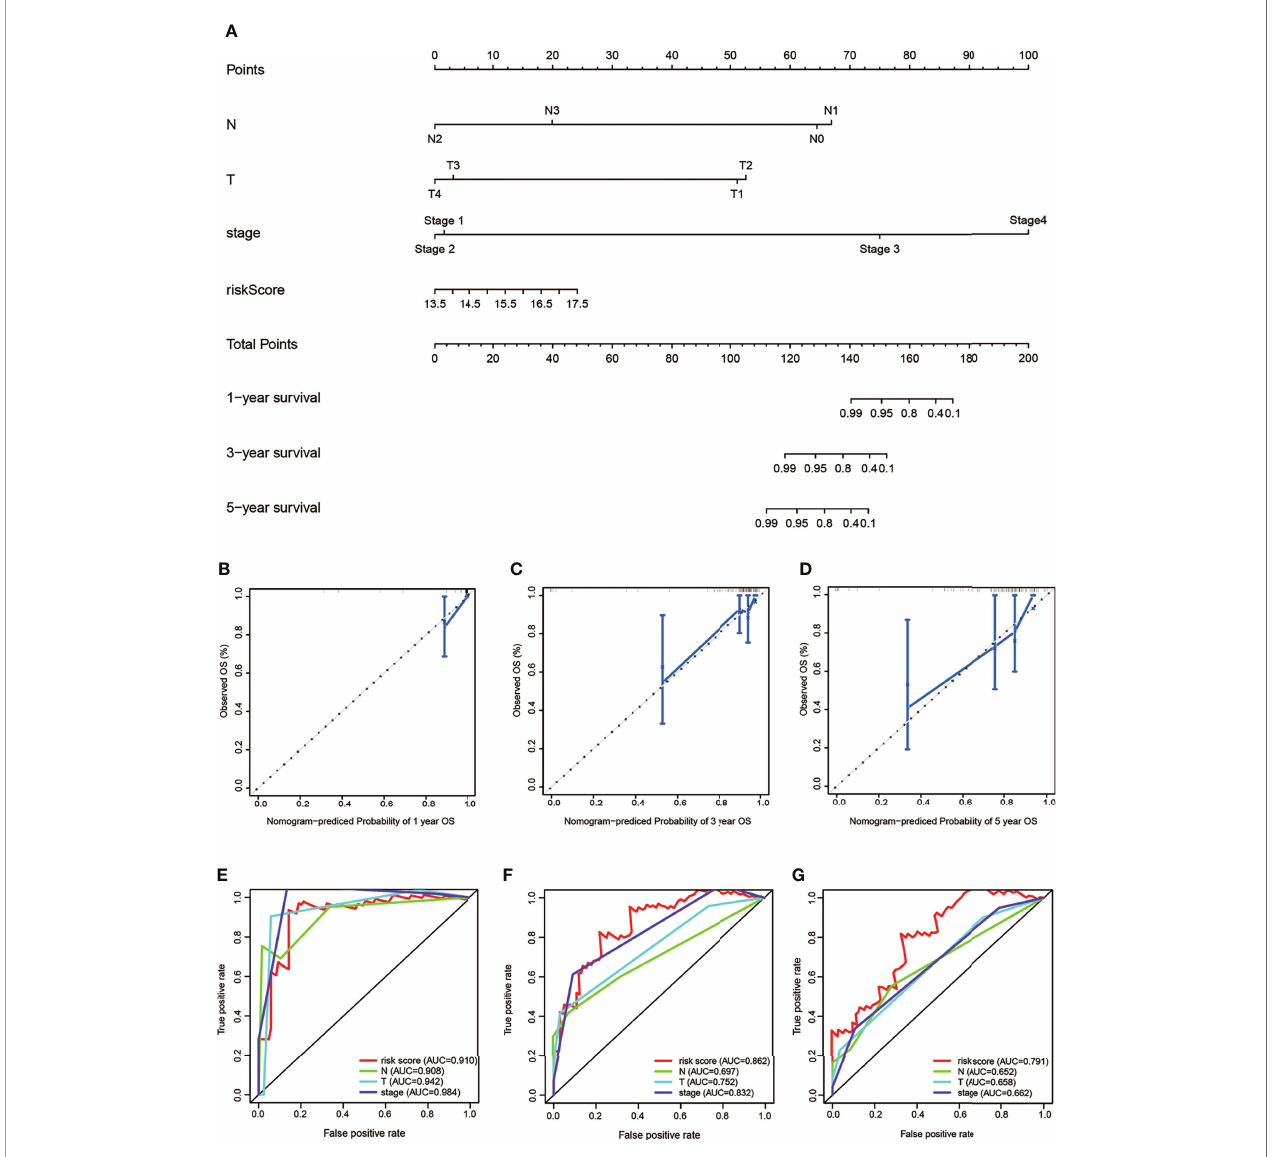
FIGURE 7 | The nomogram to predict overall survival of TNBC patients of TAGC cohort. (A) The nomogram for predicting survival proportion of patients in 1, 3-, and 5 years. (B – D) The calibration plots for predicting patient survival at 1, 3, and 5 years. (E – G) The ROC curve of OS for risk score, N, T, and stage at 1, 3, and 5